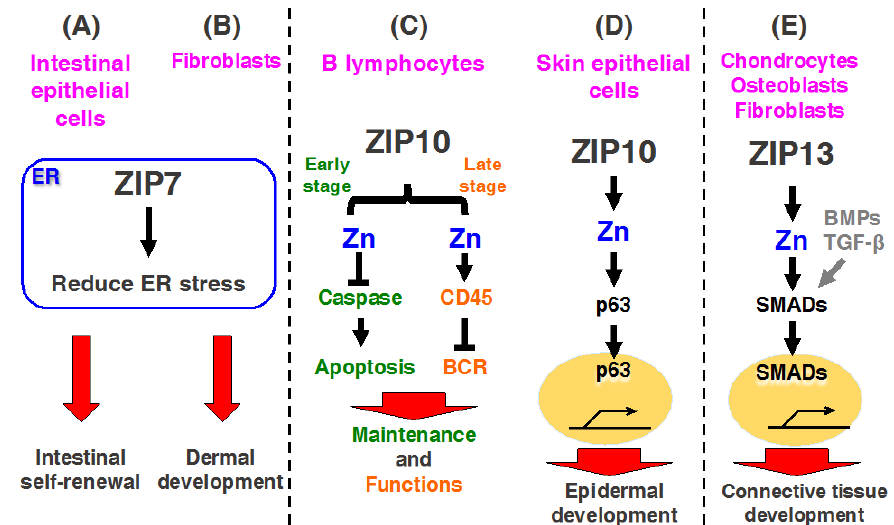
Figure 3. Biological relevance of ZIP7, ZIP10, and ZIP13. ( A , B ) ZIP7 is expressed in the endoplasmic reticulum (ER) membrane of various cells including dermal fibroblasts and intestinal epithelial cells, maintains Zn levels in the ER, and contributes to reducing ER stress. ( A ) In intestinal epithelial cells, ZIP7 promotes intestine epithelial self-renewal by resolving the upregulation of ER stress. Therefore, ZIP7 is a new regulator of intestinal epithelium homeostasis by regulating ER function; ( B ) In the dermal fibroblast ER, ZIP7 contributes dermal development. ZIP7 dysfunction induces ER stress caused by Zn-dependent protein disulfide isomerase (PDI) aggregation. PDI aggregation in dermal fibroblast disturbs adequate protein folding, which impairs dermal development; ( C , D ) ZIP10 contributes to the development and functions of B cells and skin epidermis; ( C ) ZIP10 inhibits caspase activity in progenitor B cells and promotes B cell development in the early stage (green color). ZIP10 also modulates B cell receptor (BCR) signaling in the late stage (orange color). Thus, ZIP10 is crucially involved in B cell-mediated immunity; ( D ) In skin epithelial cells, ZIP10 up-regulates p63 transactivation, which promotes epidermal and hair follicle development (yellow circle: nucleus). Therefore, the ZIP10-Zn-p63 signaling axis plays an important role in maintaining the skin epidermis; ( E ) ZIP13 is expressed in chondrocytes, osteoblasts, and fibroblasts and contributes to connective tissue development. ZIP13-mediated Zn signaling is required for Smad proteins activation in bone morphogenetic protein (BMP)/transforming growth factor beta (TGF- β ) signaling, which regulates connective tissue development.